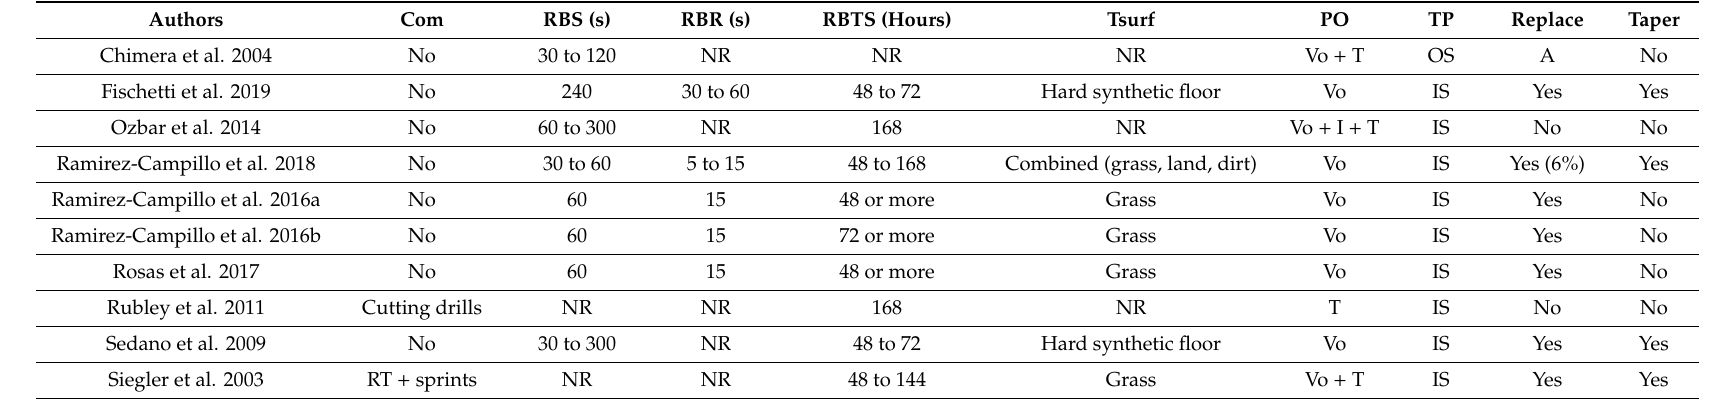
Table 2. Characteristics of PJT